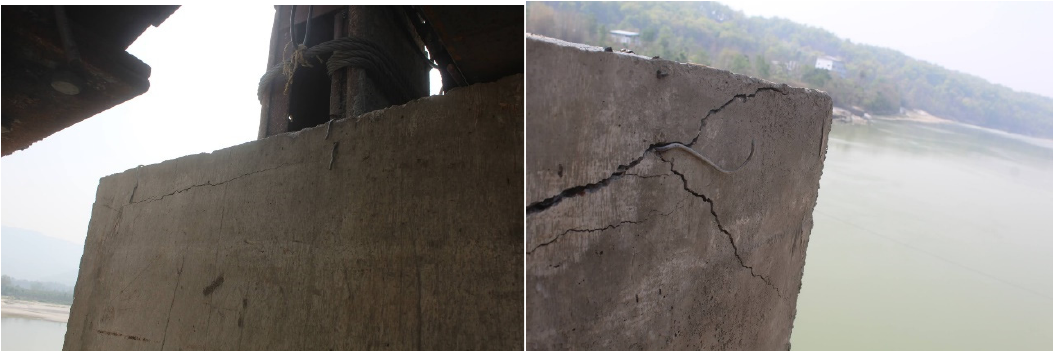
Figure 27. Damage to the RCC pedestal over pier-cap of Pier-2; steel tower was erected over it as a temporary structure for prestressing.